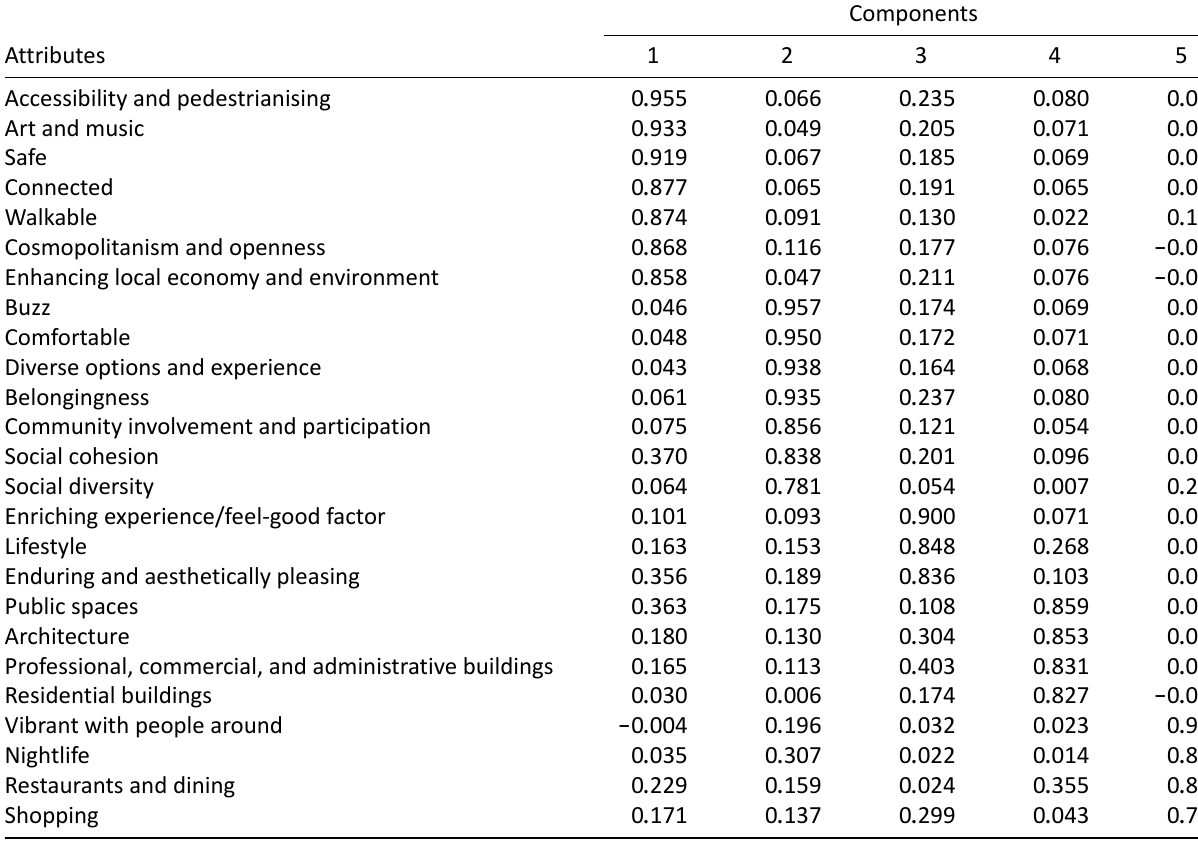
Table 7. Rotated component matrix of the principal components and attributes of central areas.